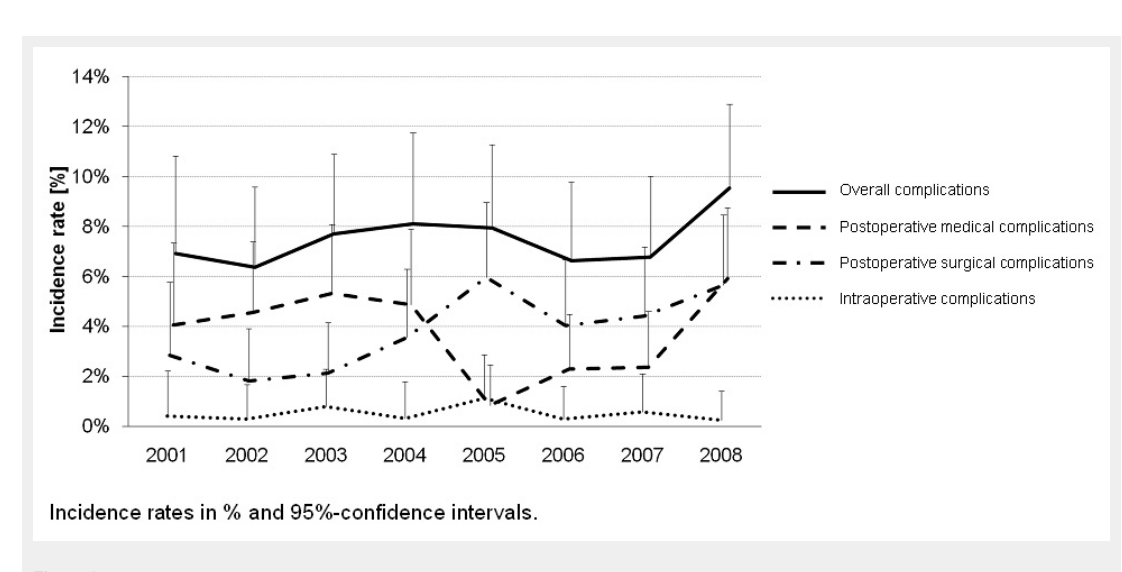
Study design. WHR: work-hour restrictions; non-common surgeries: mammary and thoracic operations, large abdominal and vessel surgeries, surgeries of the genitourinary system, treatment of hand injuries; small surgeries: excision of lymphnodes, metal removals, fracture fixations with Kirschner wires, small amputations, operations on tendons and ligaments and arthroscopies; common surgeries: herniotomy, cholecystectomy, appendectomy, thyroid surgery, proctological interventions, varicose vein operations, colorectal and small intestine surgery, and fracture fixation without Kirschner